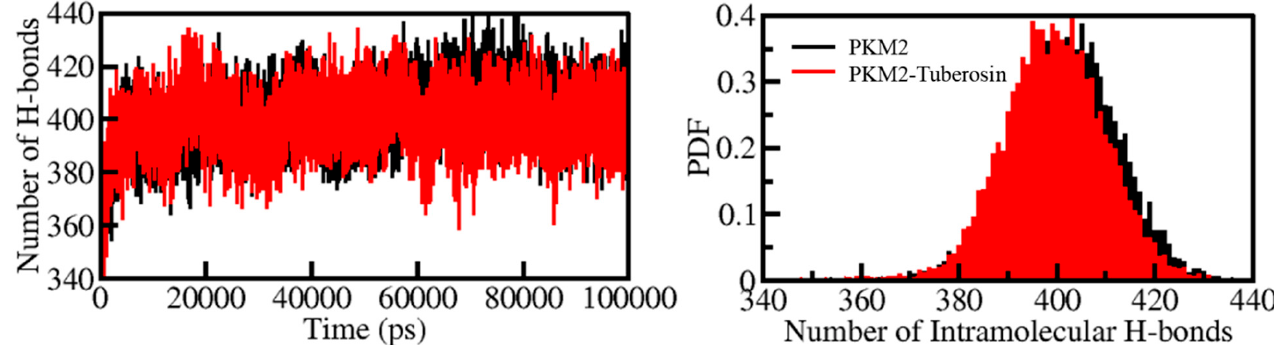
Figure 4. The dynamics of intramolecular H-bonds in PKM2 (left panel). The probability distribution of the intramolecular H-bonds in PKM2 (right panel).